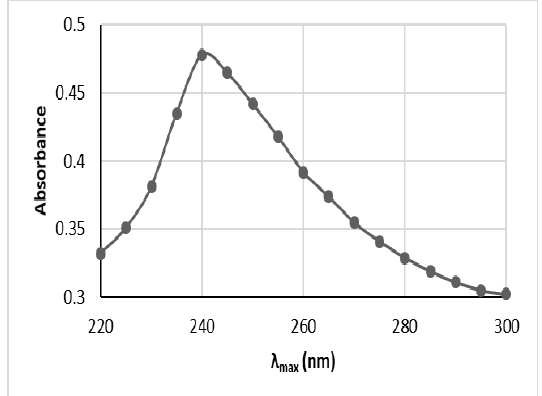
Figure 3. The scanning of ascorbic acid solution